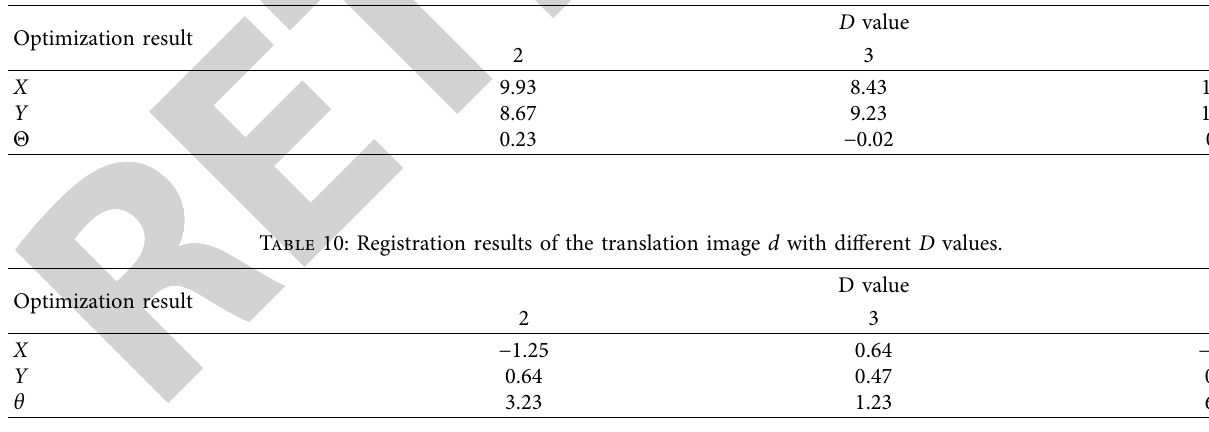
Figure 7: Compared with the traditional method. Table 9: Registration results of the translational images with different D values.